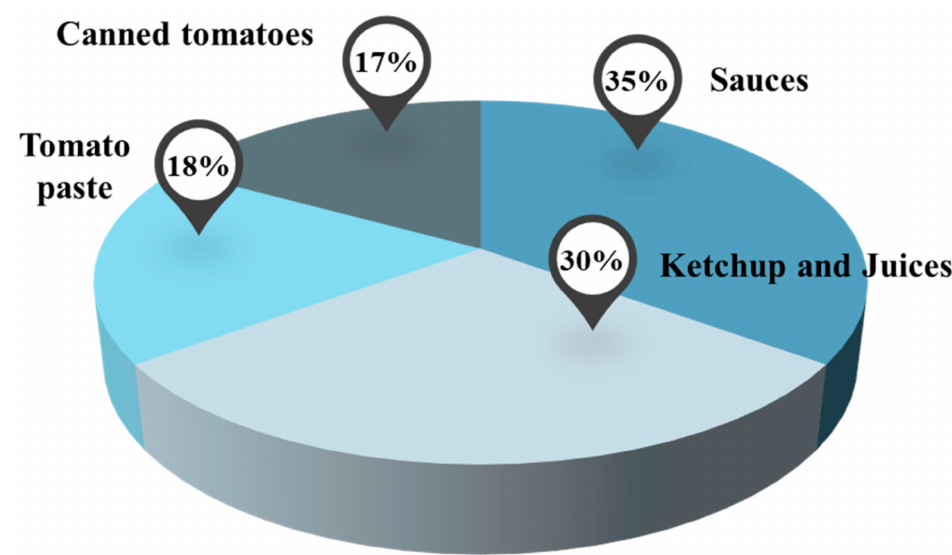
Figure 1. Graphic representation of estimated percentages of tomato processed by-products by USDA